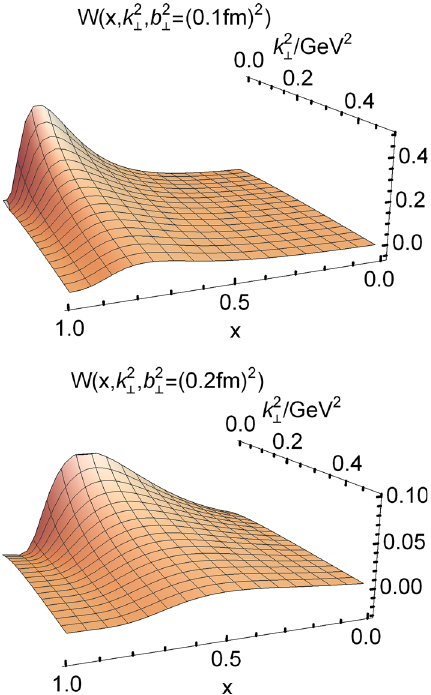
Fig. 12 Wigner distribution associated with the pion’s simplest twist- two dressed-quark GTMD in Eq. (28). The two panels display different values of | b ⊥ | , as indicated in the labels. The δ 2 ( b ⊥ ) component – first line of Eq. (80) – is suppressed in the image. Scale is ζ H , Eq.